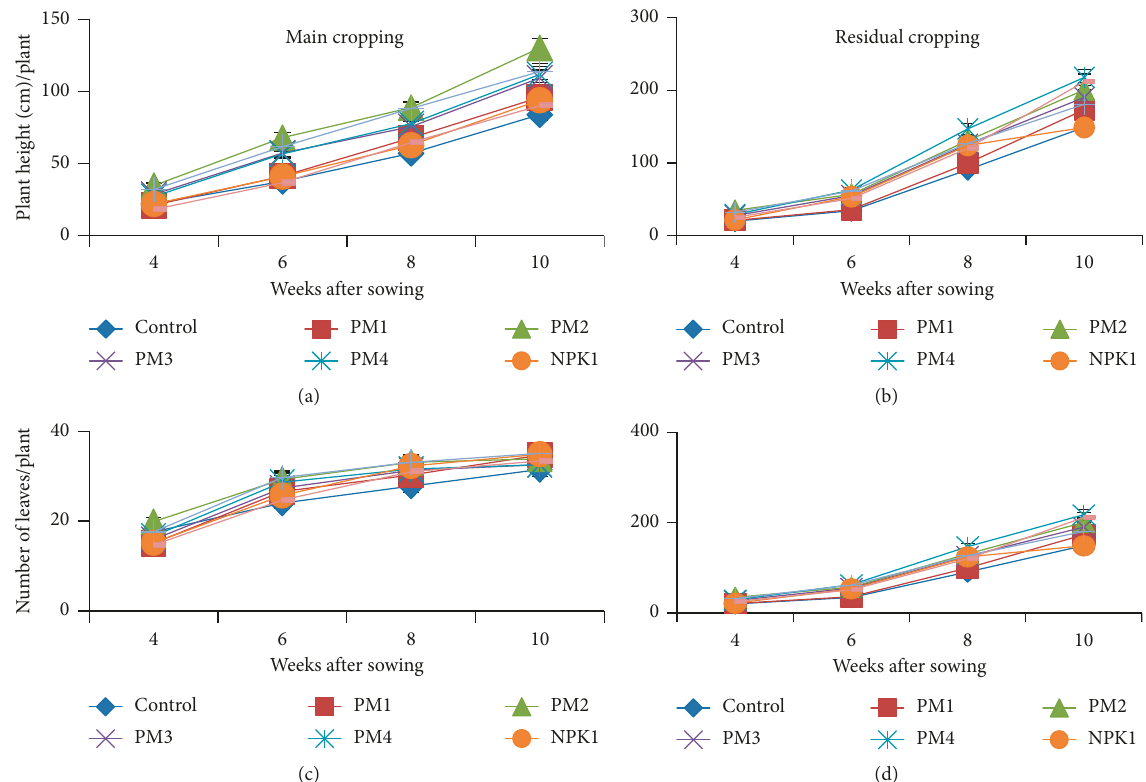
Figure 1: Effects of different rates of chicken manure and NPK fertilizers on (a) plant height (cm) and (b) number of leaves of sunflowers during main and residual cropping. PM1 � chicken manure 5t · ha − 1 ; PM2 � chicken manure 10t · ha − 1 ; PM3 � chicken manure 15t · ha − 1